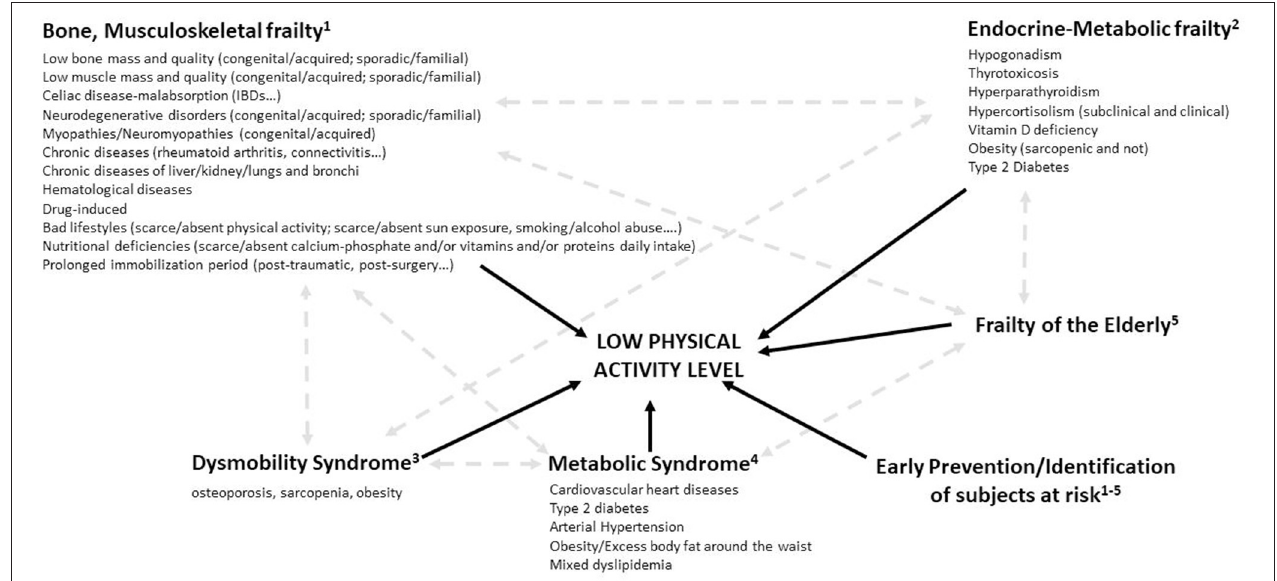
FIGURE 1 | Towards a more comprehensive concept of “global